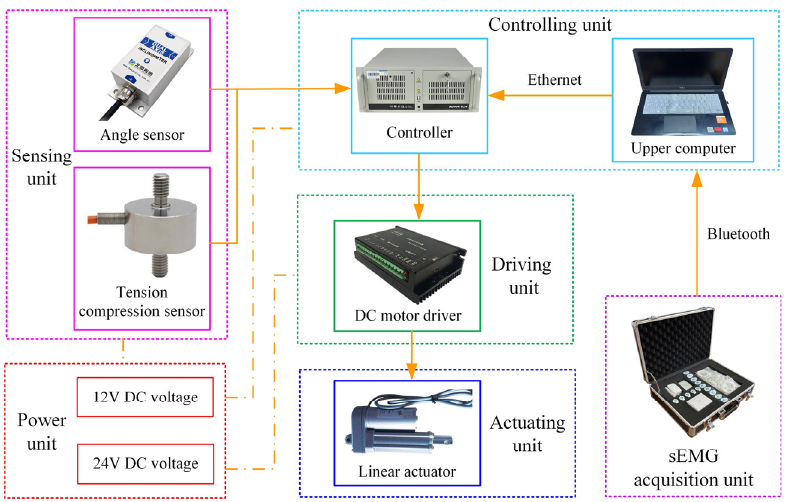
Figure 9. Frame diagram of lower limb rehabilitation robot control system.